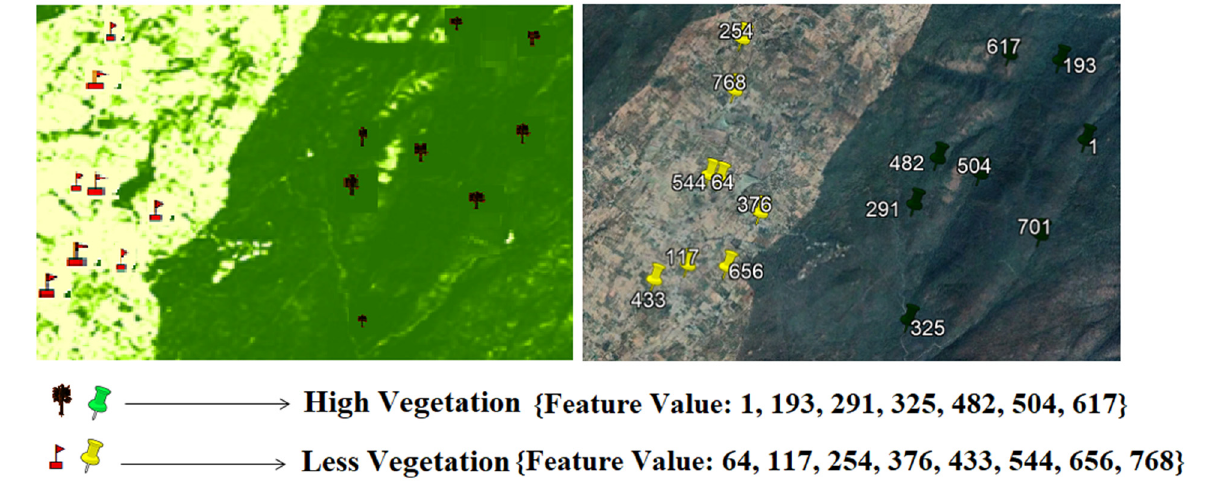
Figure 18. Validation of LU/LC classified map for the area of Javadi Hills. Table 3. Training data values for the area of Javadi Hills.